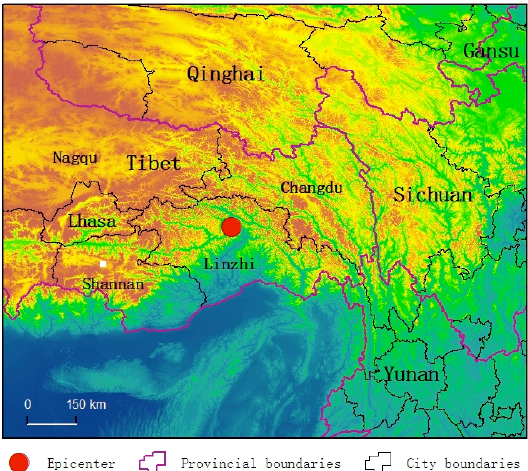
Figure 1. The location of study